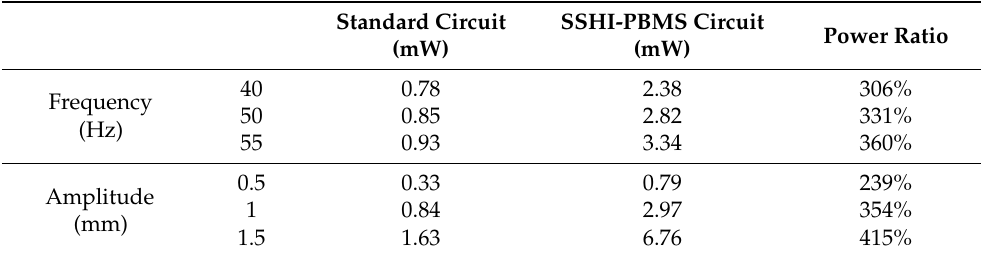
Table 2. Power comparison between SSHI-PBMS circuit and standard circuit.